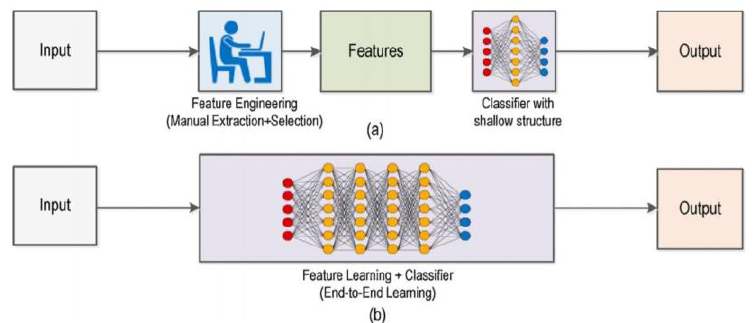
Figure 1. Comparison between traditional machine learning models ( a ) requiring manual feature extraction, and modern deep learning structures ( b ) which can automate all the feature and training process in an end-to-end learning structure.